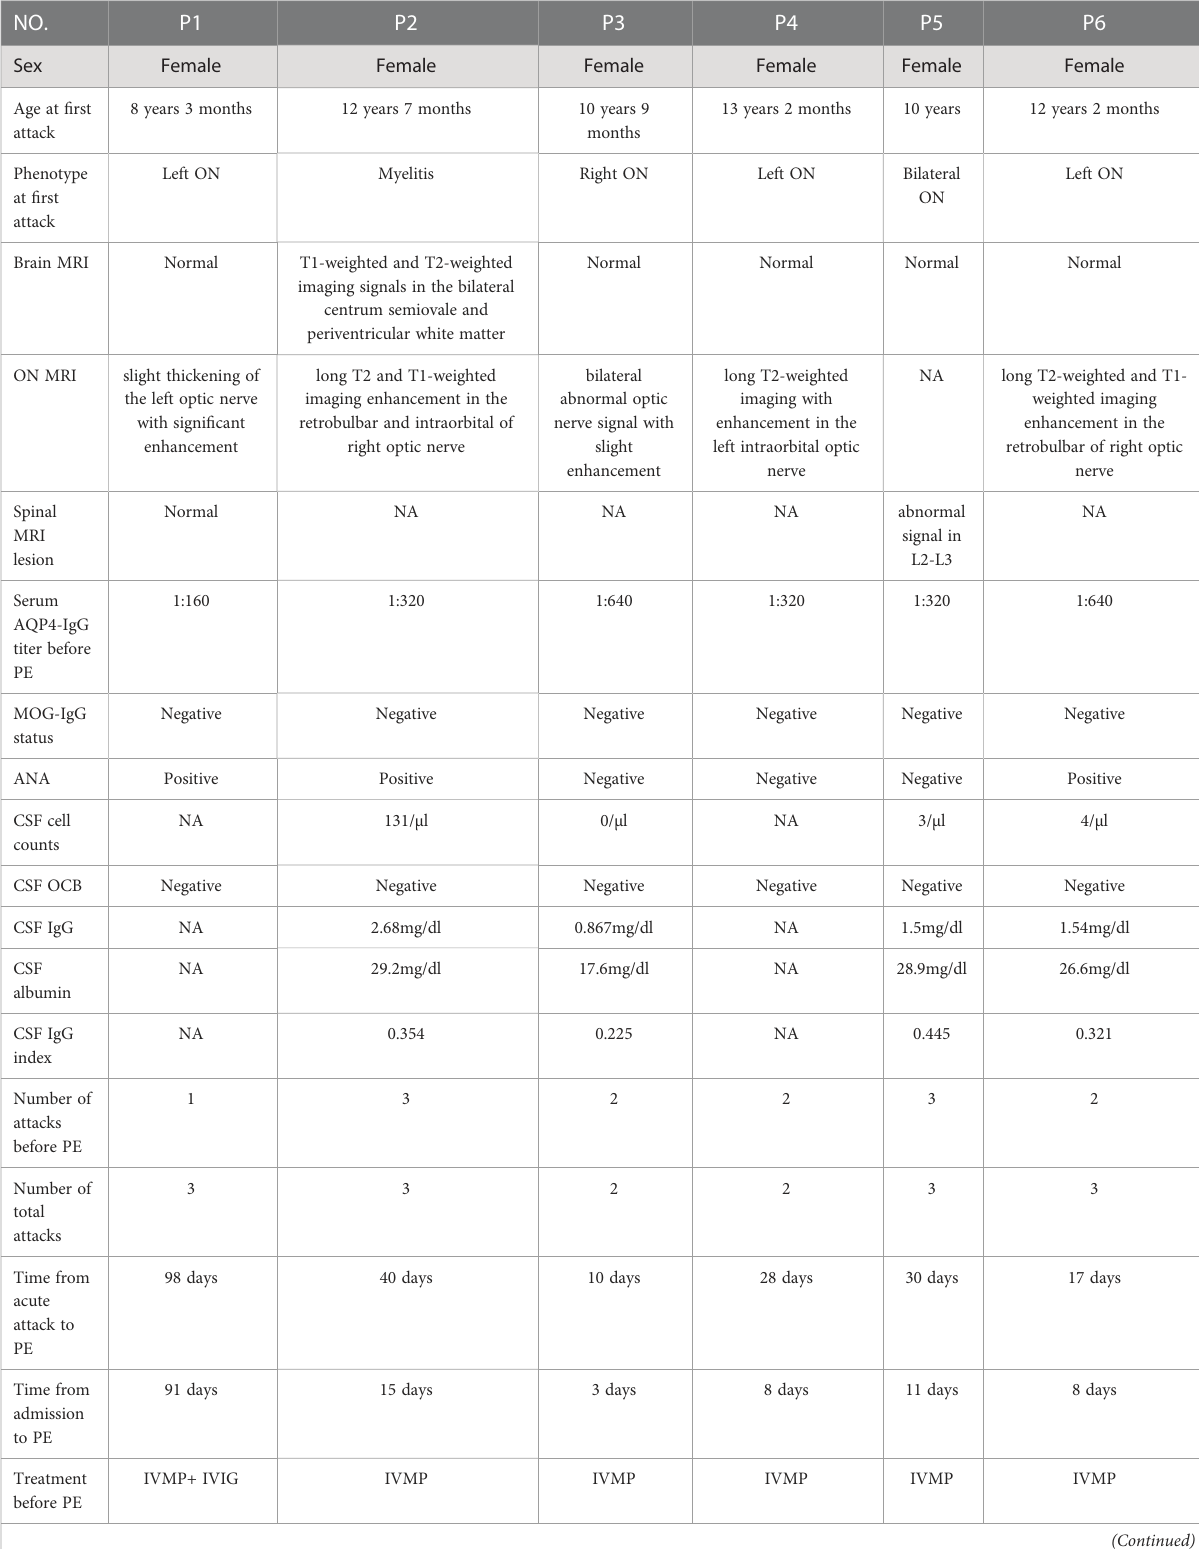
TABLE 2 Clinical phenotype of patients with